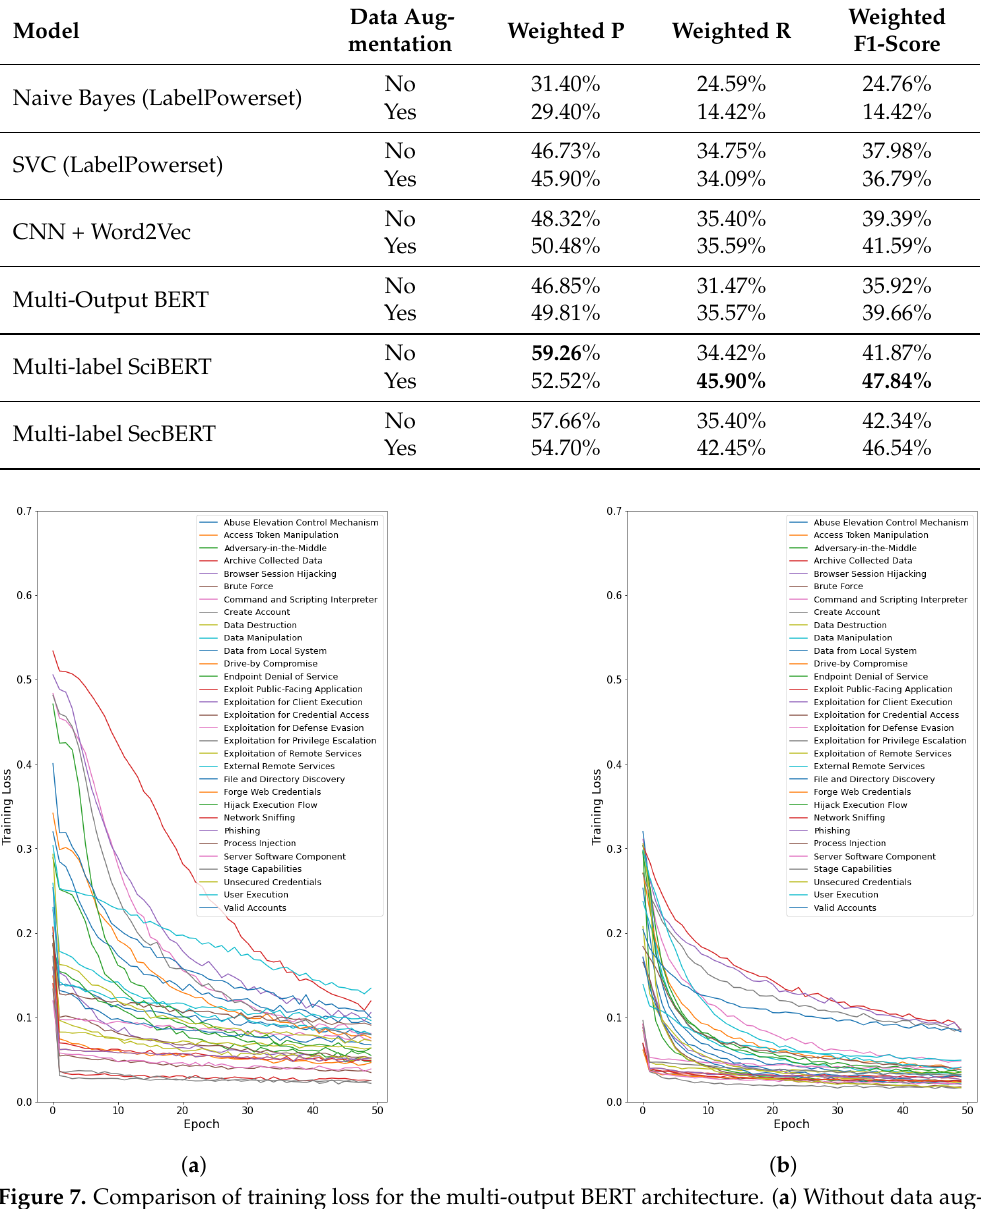
Figure 7. Comparison of training loss for the multi-output BERT architecture. ( a ) Without data aug- mentation; ( b ) With data